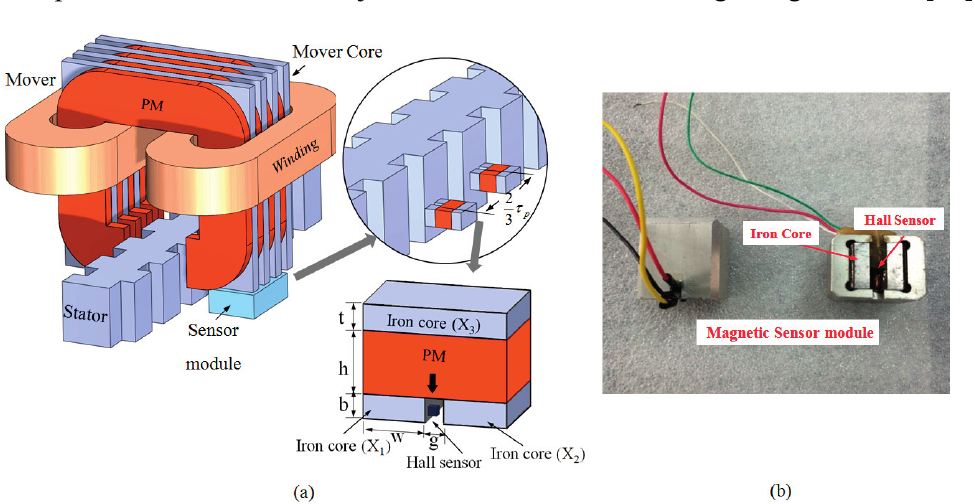
Figure 4. ( a ) Graphical representation of the arrangement of the sensor units over stator to obtain signal v a and v b ; ( b ) manufactured magnetic sensor module.